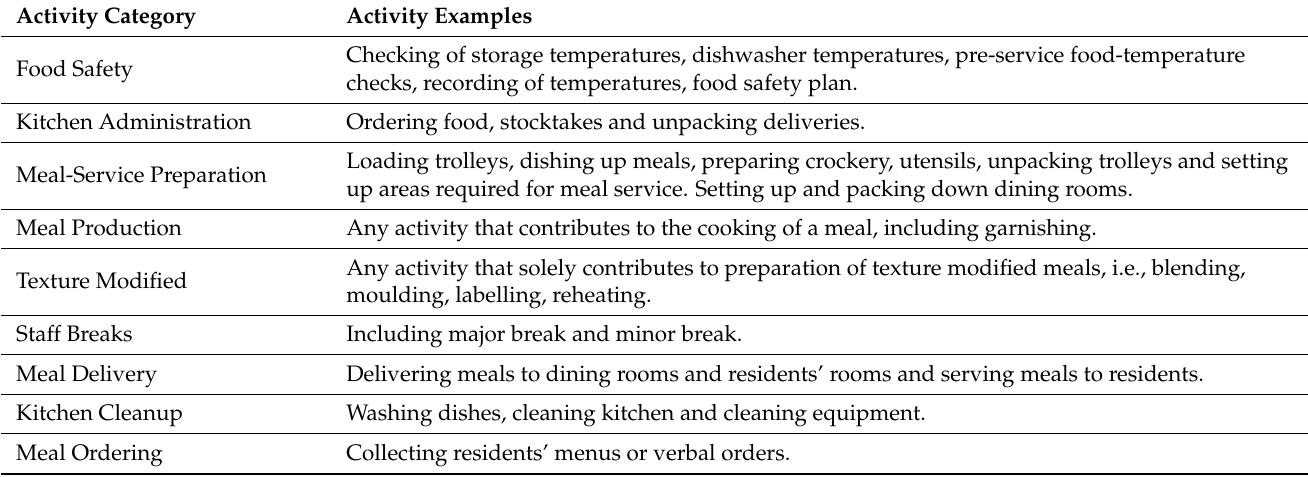
Table 2. Description of workflow